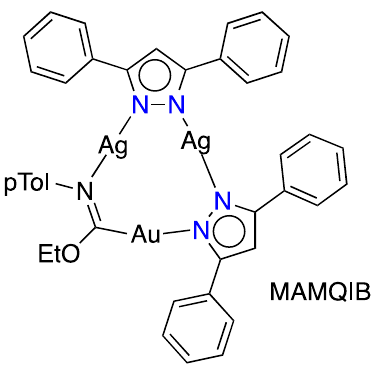
Figure 2. Structure of CSD Refcode MAMQIB.